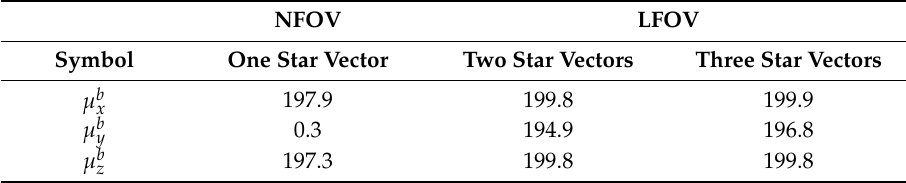
Table 3. The estimated value of installation errors in Case 3 (unit: arc-seconds).